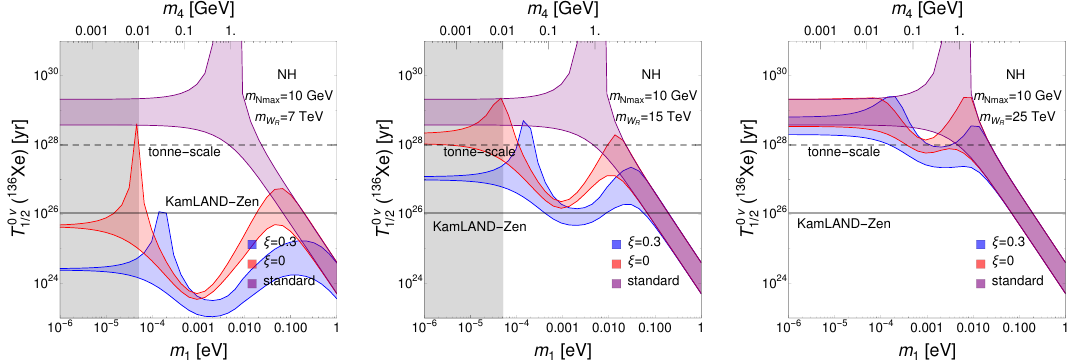
Figure 4. The same as figure 3, but with m N max = 10 GeV. The gray bands for m 4 < 10 MeV are excluded by astrophysics in the left and middle